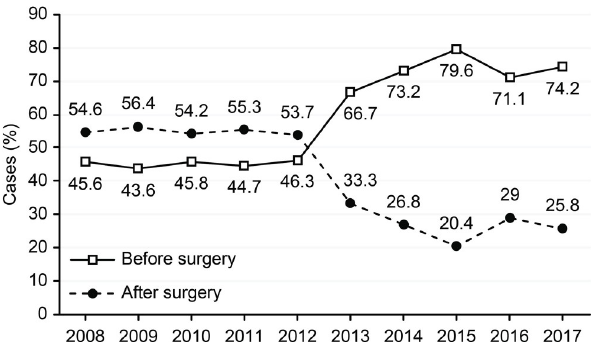
Fig 5. Percent of patients with a diagnosis of thyroid cancer before surgery and after surgery from